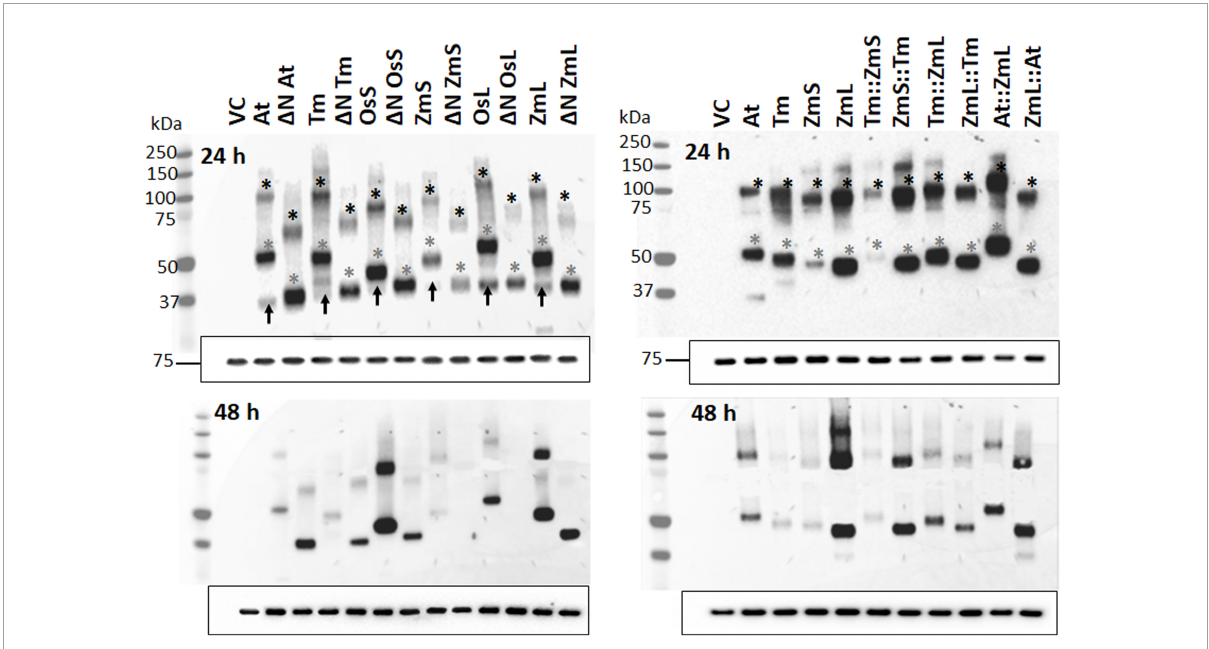
FIGURE2 Immunoblot analysis of recombinant DGAT1s located in the microsomes from Saccharomyces cerevisiae . Immunoblot analysis of microsomal proteins extracted from 24 (top panels) and 48 h cultures (bottom panels); exposure time of the latter was approximately 10 times longer than those on the top. Gels were loaded based on equal quantities of Kar2 reference protein (Rose et al., 1989) shown by the 75 kDa band at the bottom of each immunoblot (similar results were obtained when the immunoblots were loaded on equal levels of total microsomal protein, not shown). Gray asterisks indicate recombinant DGAT1 monomers; expected monomeric sizes (kDa): At (62.7), (cid:49) N At (52.9), Tm (62.6), (cid:49) N Tm (53.3), OsS (58.9), (cid:49) N OsS (54.1), ZmS (60.1), (cid:49) N ZmS (53.7), OsL (63.4), (cid:49) N OsL (53.3), ZmL (61.3), (cid:49) N ZmL (53.3), Tm:ZmS (63.1), ZmS:Tm (59.6), Tm:ZmL (62.8), ZmL::Tm (61.0), At::ZmL (63.2), and ZmL::At (60.9). Black asterisks indicate dimerized DGAT1s. Black arrows in the top left-hand panel indicate C-terminal fragments from full length DGATs that have been autonomously N-terminally cleaved by S. cerevisiae . From